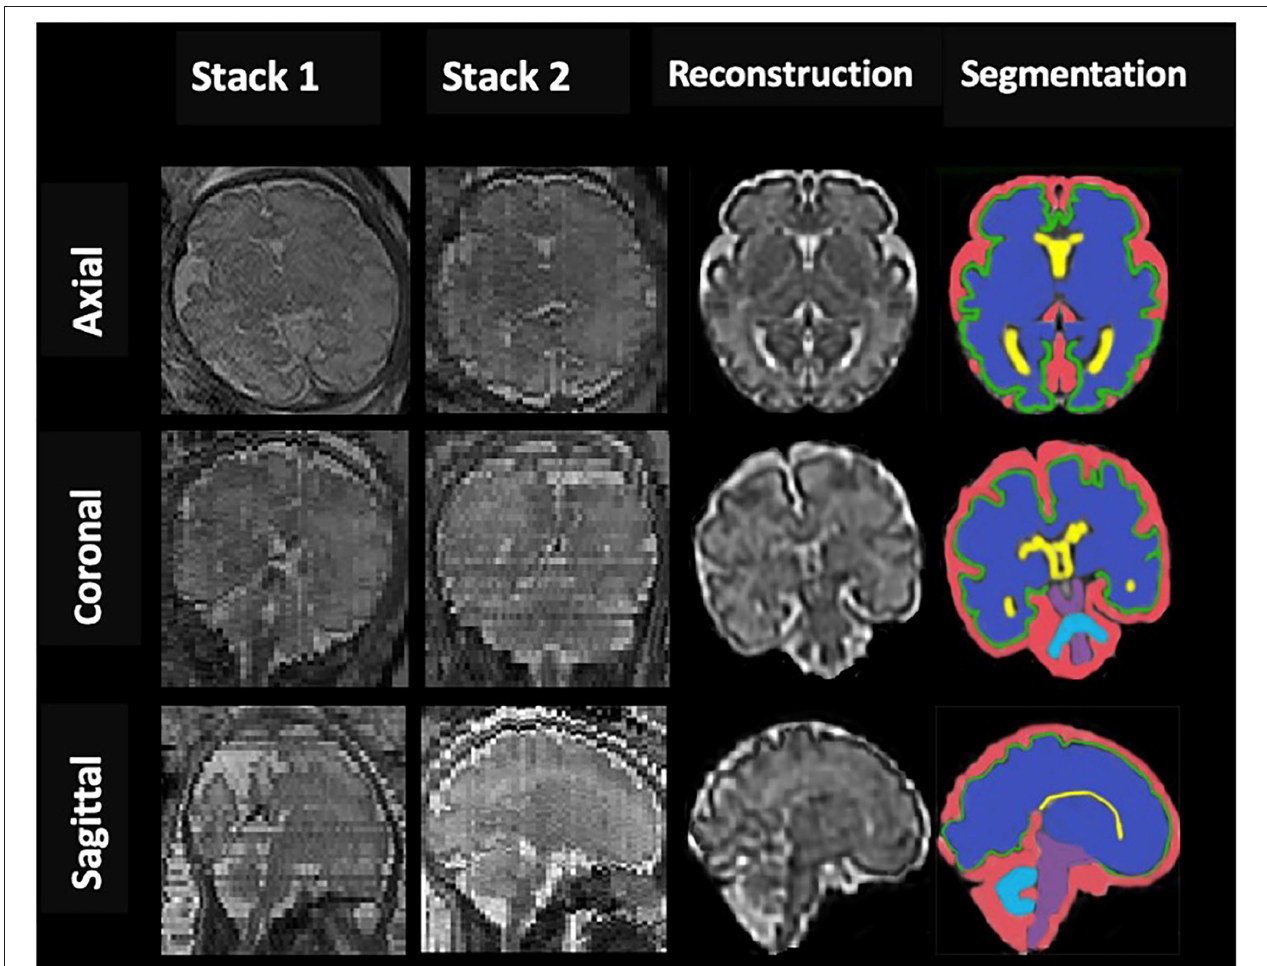
FIGURE 1 | An example of fetal brain reconstruction from two dimensional (2D) single-shot fast spin-echo (SSFSE) MRI slices of axial, sagittal, and coronal planes (Stack1; 2) to a single three dimensional (3D) reconstruction volumetric image (reconstruction column); 3D reconstructed brain of a normal control fetus at 32 gestational weeks with manual 3D segmentations of supratentorial brain tissue, lateral ventricles, cortex, cerebellum, brainstem (BM), and extra-cerebrospinal fluid volume (eCSF) (segmentation